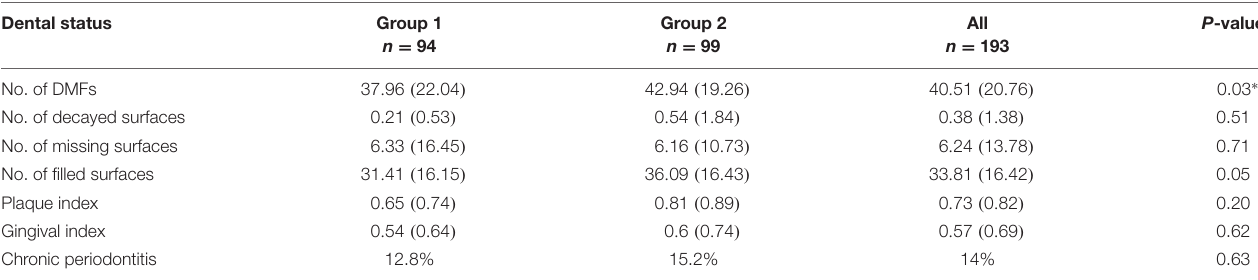
TABLE 5 | Dental and oral health measures in group 1 and 2 as well as in the whole study